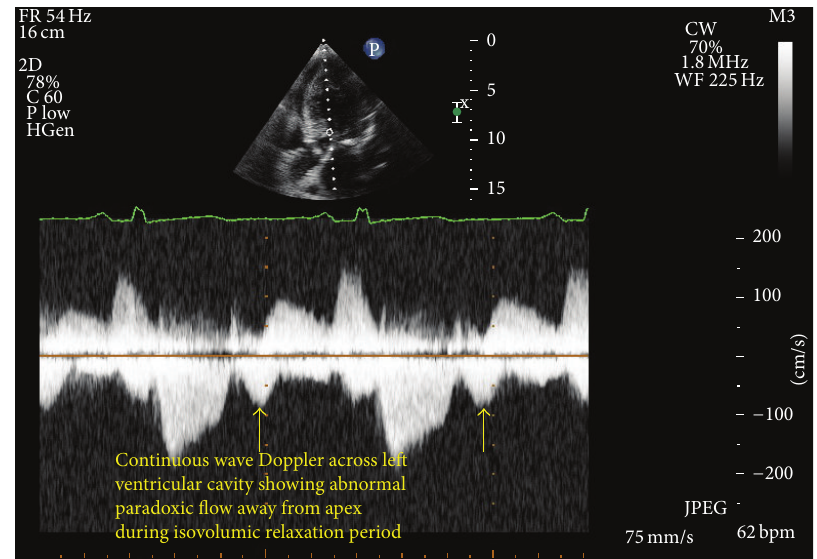
Figure 4: Doppler flow pattern across midventricular obstructive ventricle.